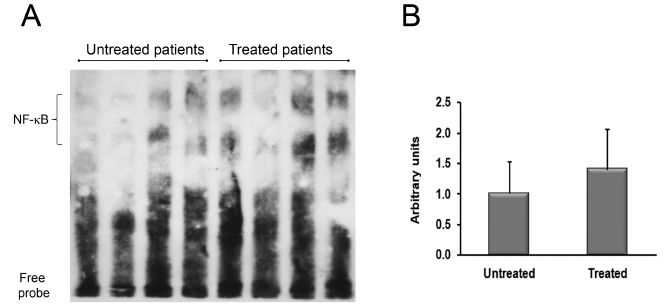
Figure 3. Analysis of NF- κ B activation in nuclear extracts from foreskins of BXO patients untreated or treated with OZOILE ® . DNA binding activity of NF- κ B was determined by the electrophoretic mobility shift assay (EMSA). This picture is representative of foreskin tissues from untreated ( n = 15) and treated ( n = 15) patients. The densitometric analysis of all samples is also reported. The results are expressed as mean ± SEM.